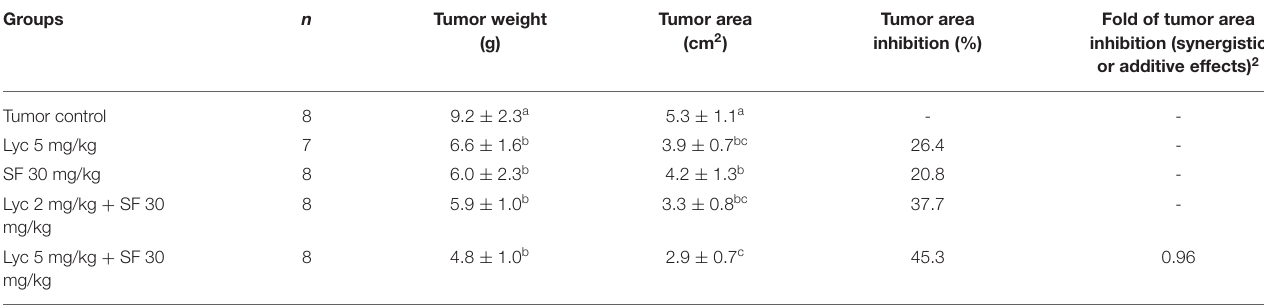
TABLE 2 | Inhibitory effects of lycopene (Lyc) alone, sorafenib (SF) alone, or their combination on the primary tumor area and tumor weight in the C57BL/6 mice xenografted LLC cells 1 . Groups n Tumor weight